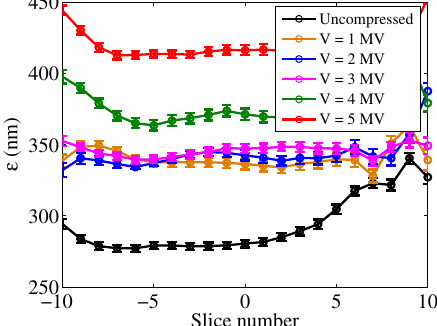
FIG. 8. Observed horizontal slice emittance along the bunch for different deflecting voltages ( V ) of the transverse deflecting cavity. The compression factor is fixed to 5 (dipole bending angle 4.07°). Two measurements performed on the uncompressed beam under equal conditions are shown for reference.